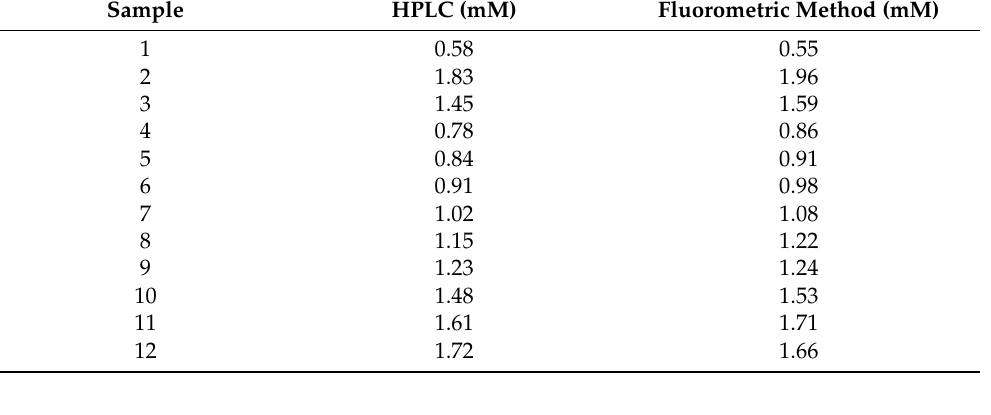
Table 1. GSH concentrations of different RBCs samples obtained by the direct optimized method and the validated HPLC one. RSD for all reported values was ≤ 5%.